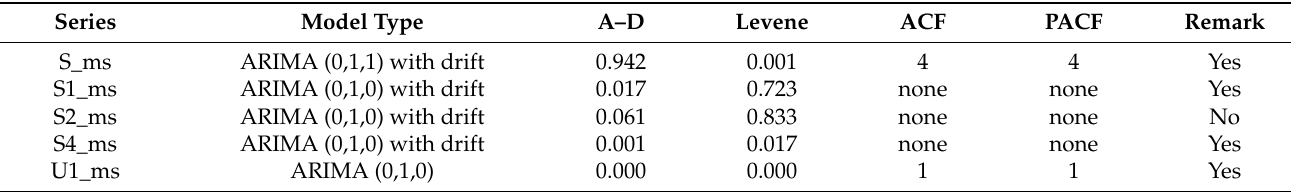
Table 21. Results of the statistical tests on the residual from ARIMA models for the monthly deseasonalized series. Series Model